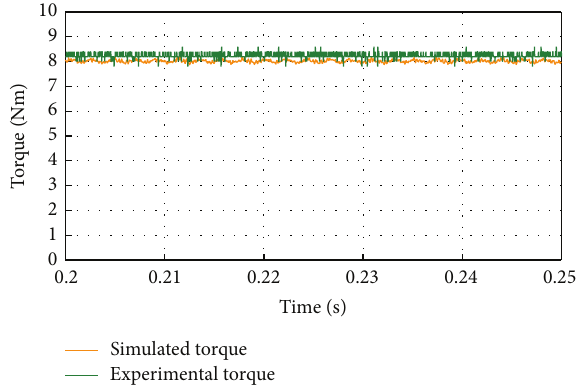
Figure 14: Comparison of output torque between simulation and experimental results.